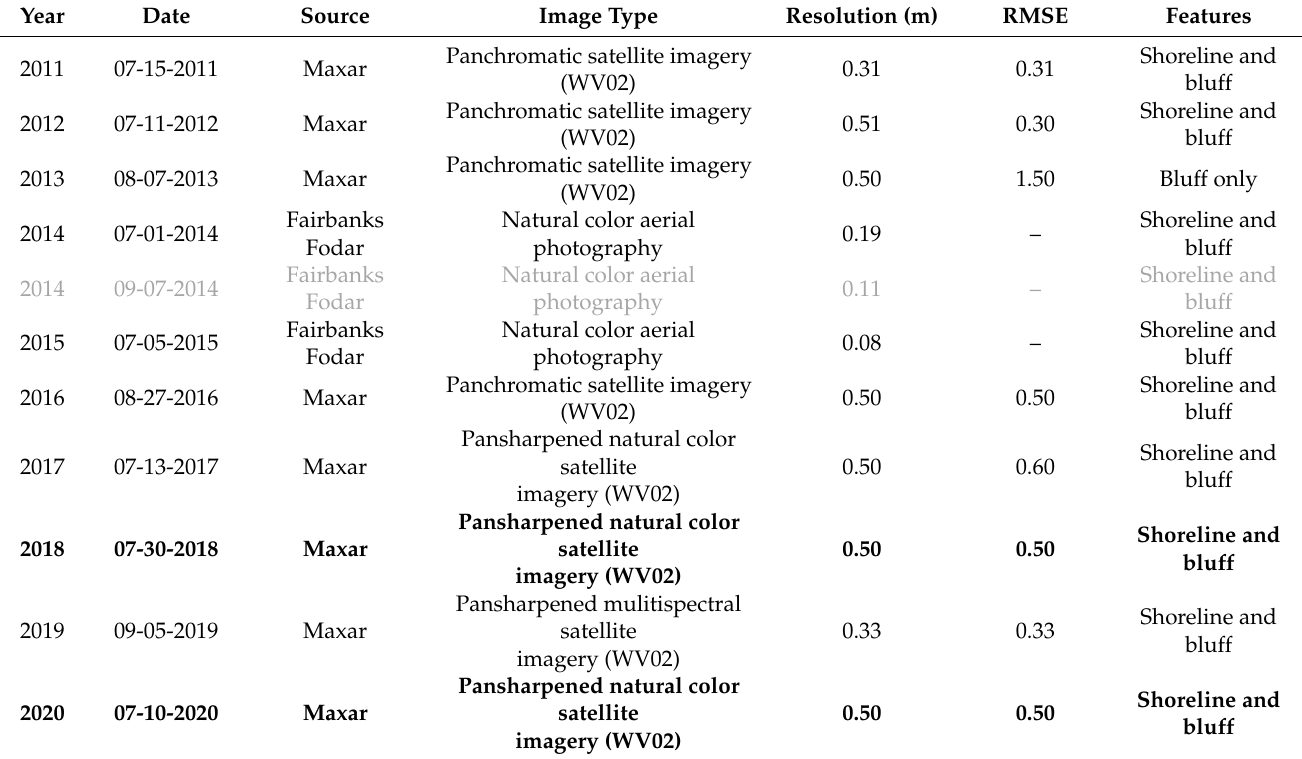
Bold text indicates shoreline datasets used in this analysis; grayed text indicates bluff and shoreline positions are included in [29] but not used in this analysis. Change rates were calculated every 10 m alongshore using the Digital Shoreline Analysis System 5.0 [37] using either the linear regression or endpoint rate